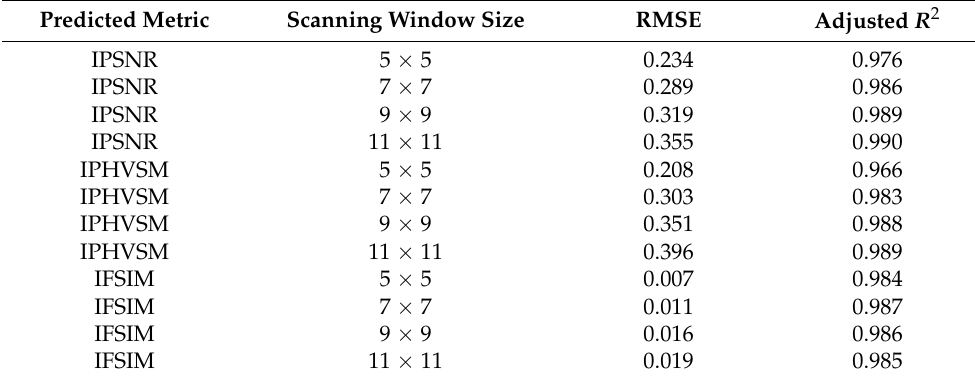
Table 1. Self-dataset validation on the same Sentinel-2 data, channel #11.